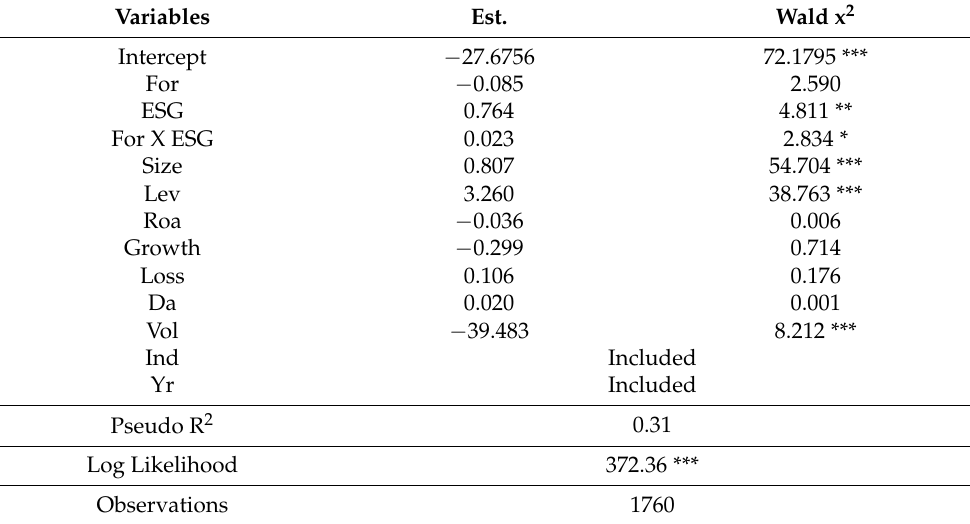
Table 6. The effect of ESG on the relationship between foreign investors and voluntary